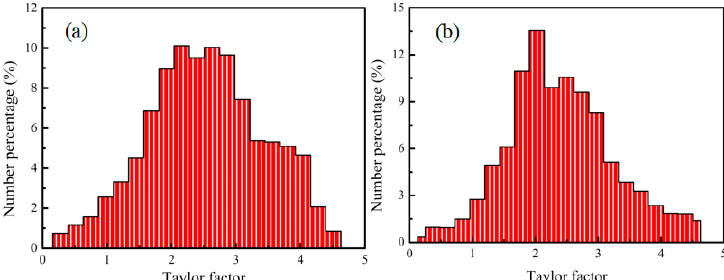
Figure 17. Comparison between the inter-layer area and deposited area on the Taylor factor: ( a ) Inter-layer area; ( b ) deposited area.